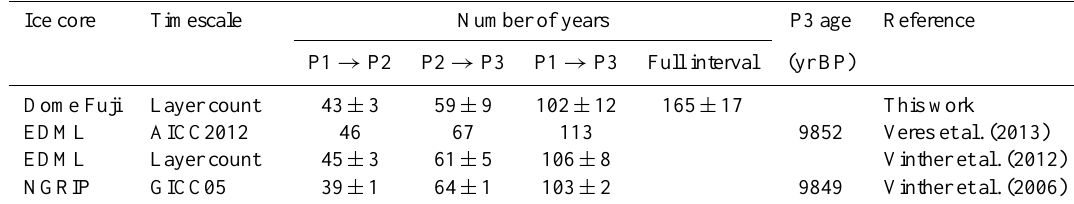
Table 2. The number of years between the characteristic acidity spikes P1, P2, and P3 (see Table 1). AICC2012 is the Antarctic Ice Core Chronology